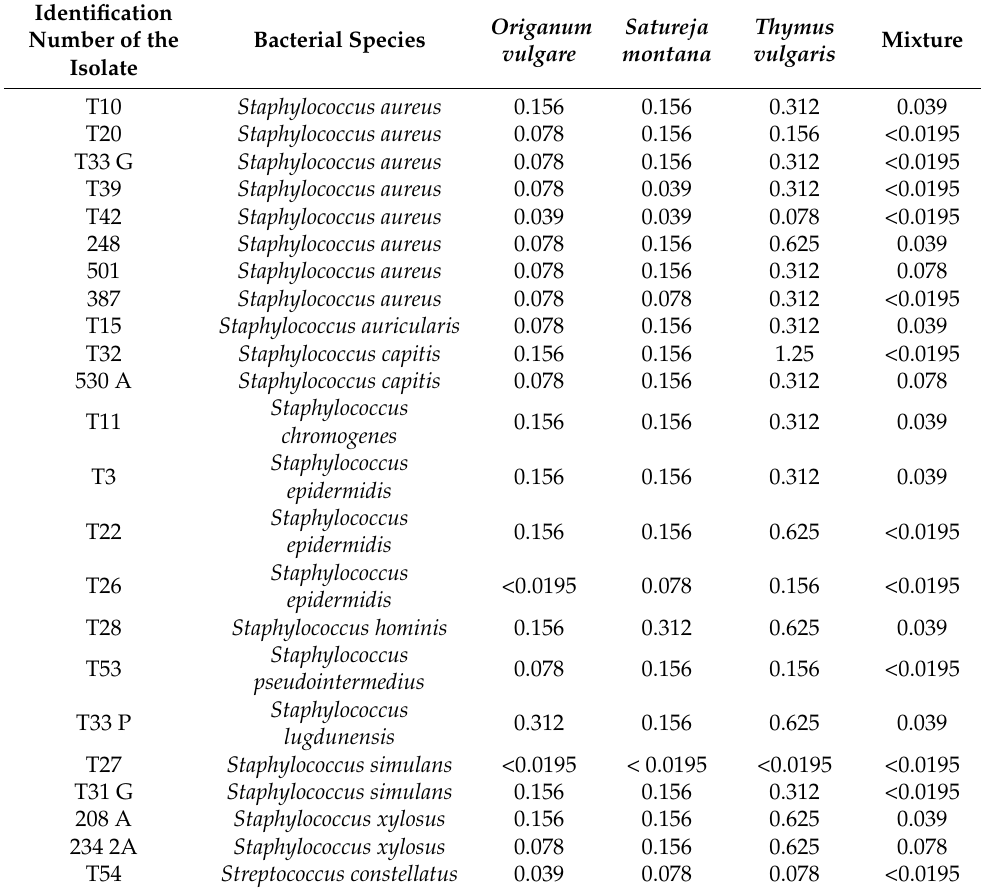
Table 2. MIC values of the tested EOs and mixture expressed in percentage ( v / v ) against the selected Gram-positive